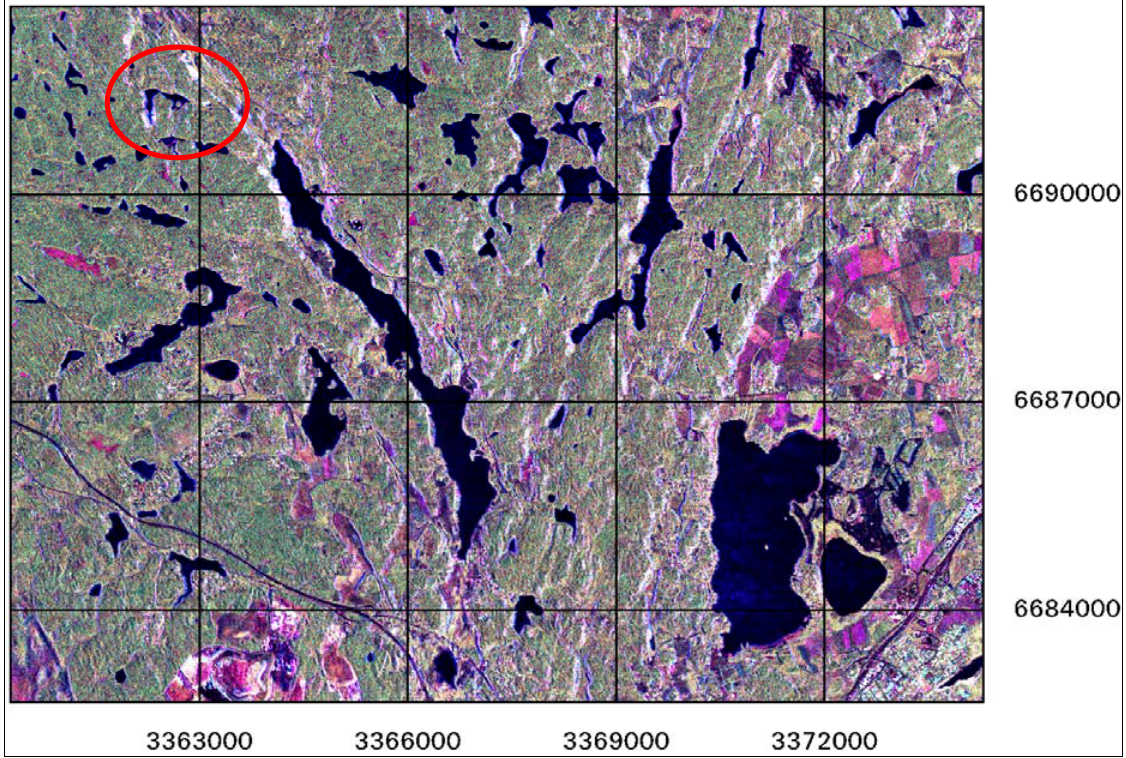
Figure 1. False color fusion of all used TerraSAR-X images (Red: average amplitude of co-polarized image channels, Green: average amplitude of cross-polarized image channels, and Blue: standard deviation of amplitude of all image channels). Map projection: